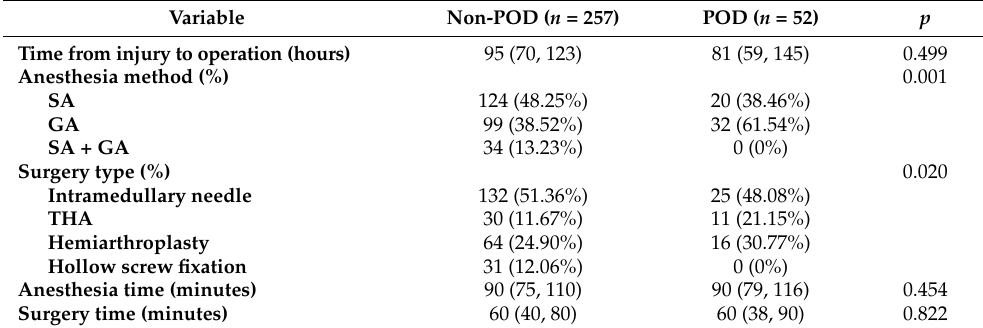
Table 2. Intra-operative data.